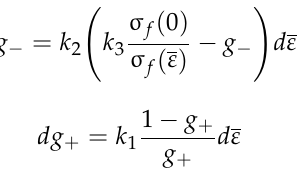
2002, Yoshida, F. et al. Yoshida, F. et